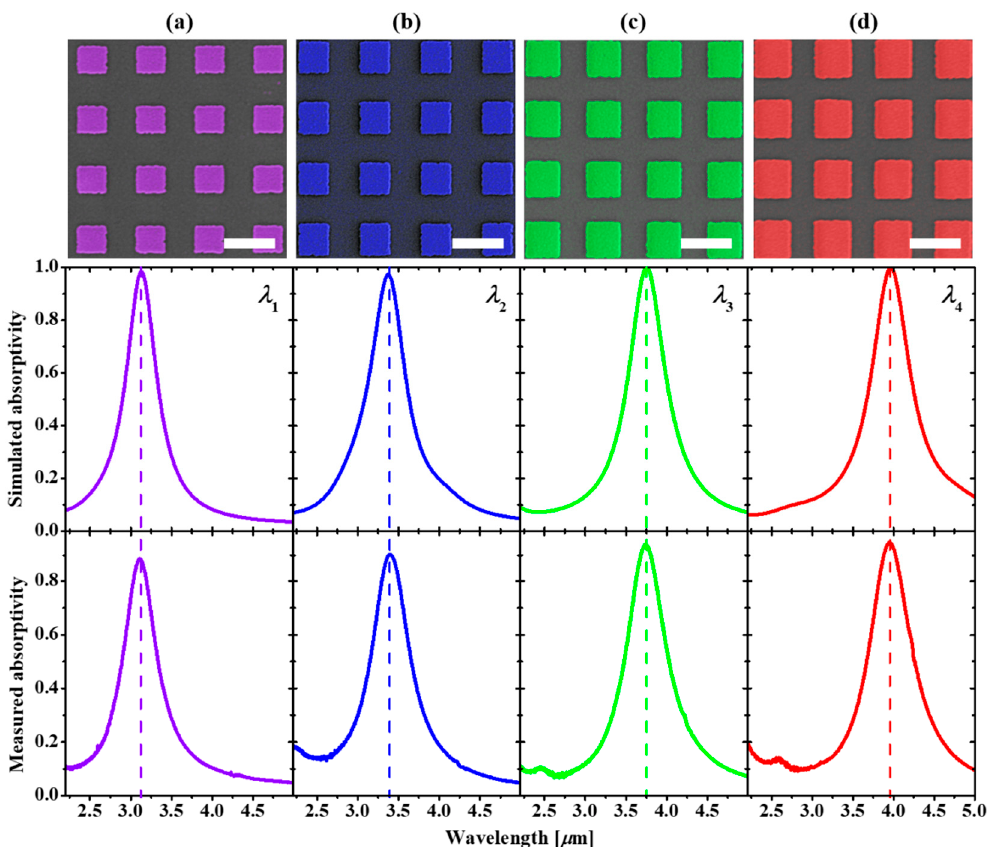
Figure 4. Resonance tunability in the MIR atmospheric window region of the MEMS wavelength- selective bolometers. ( a )–( d ) From top to bottom panels: top-view SEM images (with colors), simulated (middle) and measured (bottom) absorptivities of a quad-wavelength bolometers chip having resonances at 3.11 µm, 3.39 µm, 3.73 µm and 3.96 µm. The scale bar is 1 µm for all SEM images.